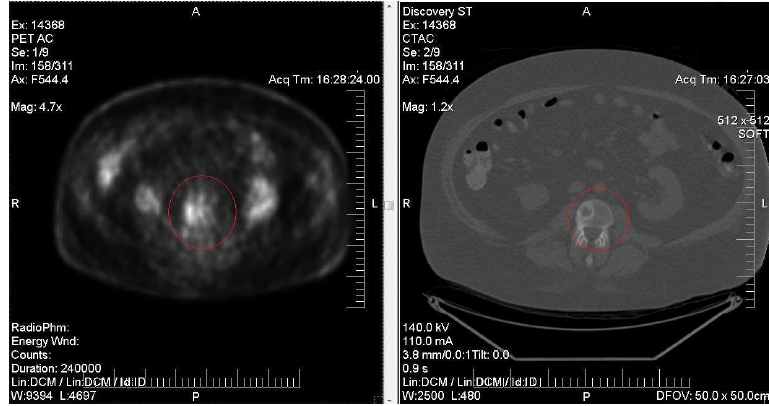
Figure 2. Abnormal hypermetabolism corresponding to L3 vertebra.